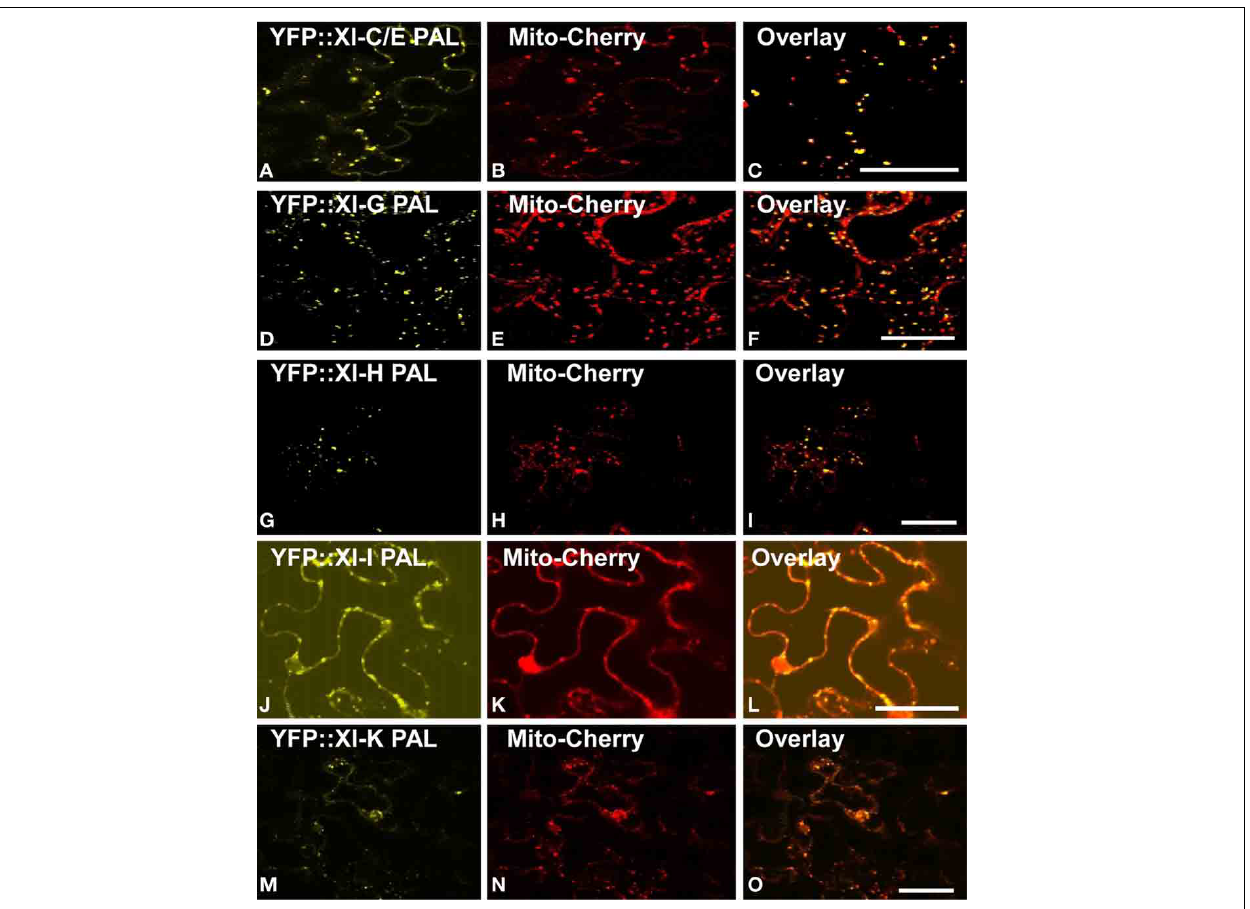
FIGURE 4 | Co-Expression of YFP::Myosin XI PAL sub-domain with mCherry markers for mitochondria in epidermal leaf cells of N. benthamiana . (A) At XI-C. (D) At XI-I G. (G) At XI-H. (J)